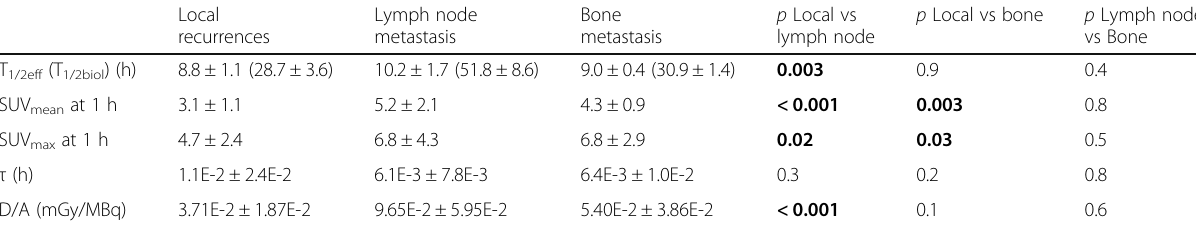
Table 1 Summary table of the main tumour